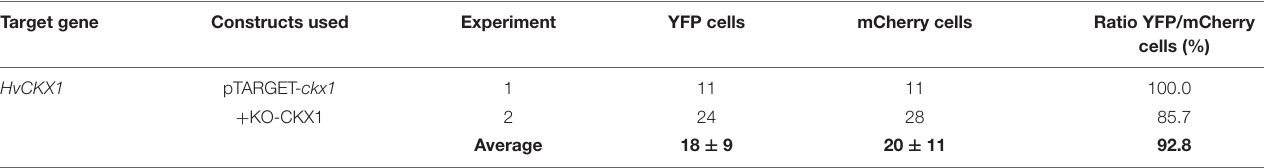
TABLE 1 | Relative cleavage activity of KO-CKX1 construct in transiently transformed barley epidermal cells. Target